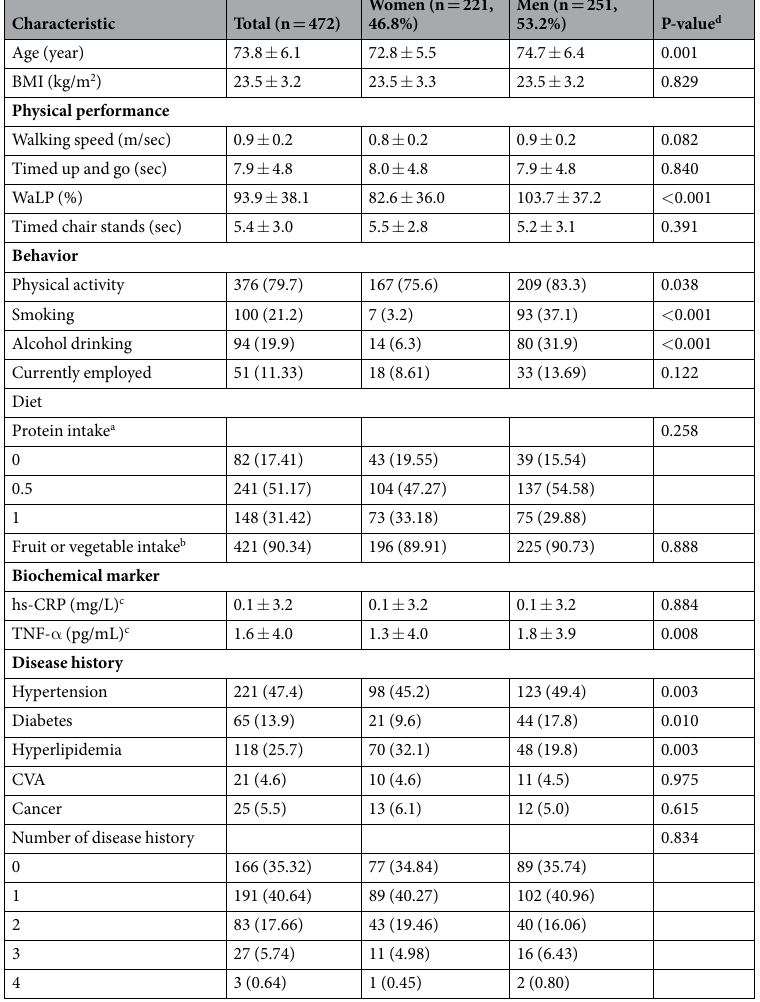
Table 1. Characteristics of study subjects. Data are presented as mean ± SD for continuous variables or n (%) for categorical variables. BMI: body mass index; hs-CRP: high-sensitivity C-reactive protein; CVA: cerebral vascular accident. a: Mini nutritional assessment (MNA) questionnaire: selected consumption markers for protein intake, including (1) at least 1 serving of dairy products per day, (2) two or more servings of legumes or eggs per week, and (3) meat, fish or poultry every day. 0 = if 0 or 1 yes, 0.5 = if 2 yes, and 1 = if 3 yes. b: MNA questionnaire: consumes two or more servings of fruit or vegetables per day. c: Geometric mean was presented. d: Two-sample t-test for continuous variables or χ 2 -test for categorical